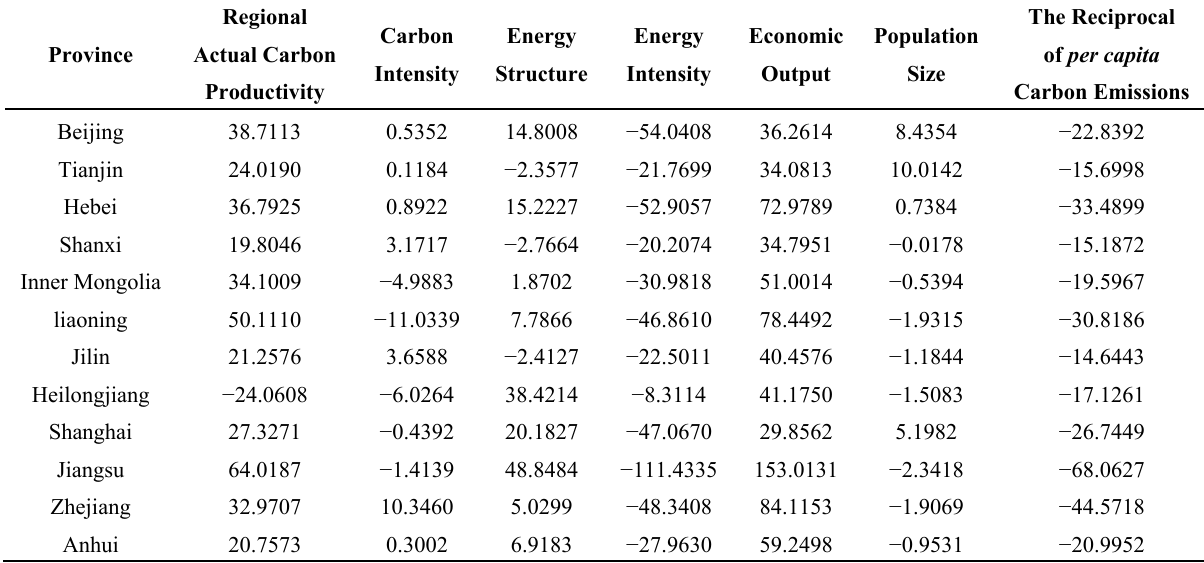
Table 1. Different parts of Chinese influence factors’ contribution values to carbon